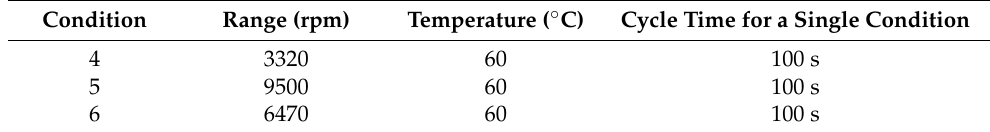
Figure 28. Speed-changing operating condition. 5.3. Optimization of the Number of Cycles The accelerated test load spectrum of the motor rotor is compiled to reproduce the effects of damage under different road sections simultaneously when reproducing the 300,000 km total damage. It is crucial to reproduce damage at different constant speed temperatures as well as damage at different speed range variations. Therefore, the deter- mination of the cycle times of the whole test condition is a typical multivariate and multi- objective optimization problem [24]. NSGA-II is one of the most commonly used multi-objective genetic algorithms in en- gineering applications. It is an optimization algorithm based on the first-generation algo- rithm and has the advantages of fast convergence, wide applicability, and good robust- ness. The specific solution process of the NSGA-II algorithm is shown in Figure 29.